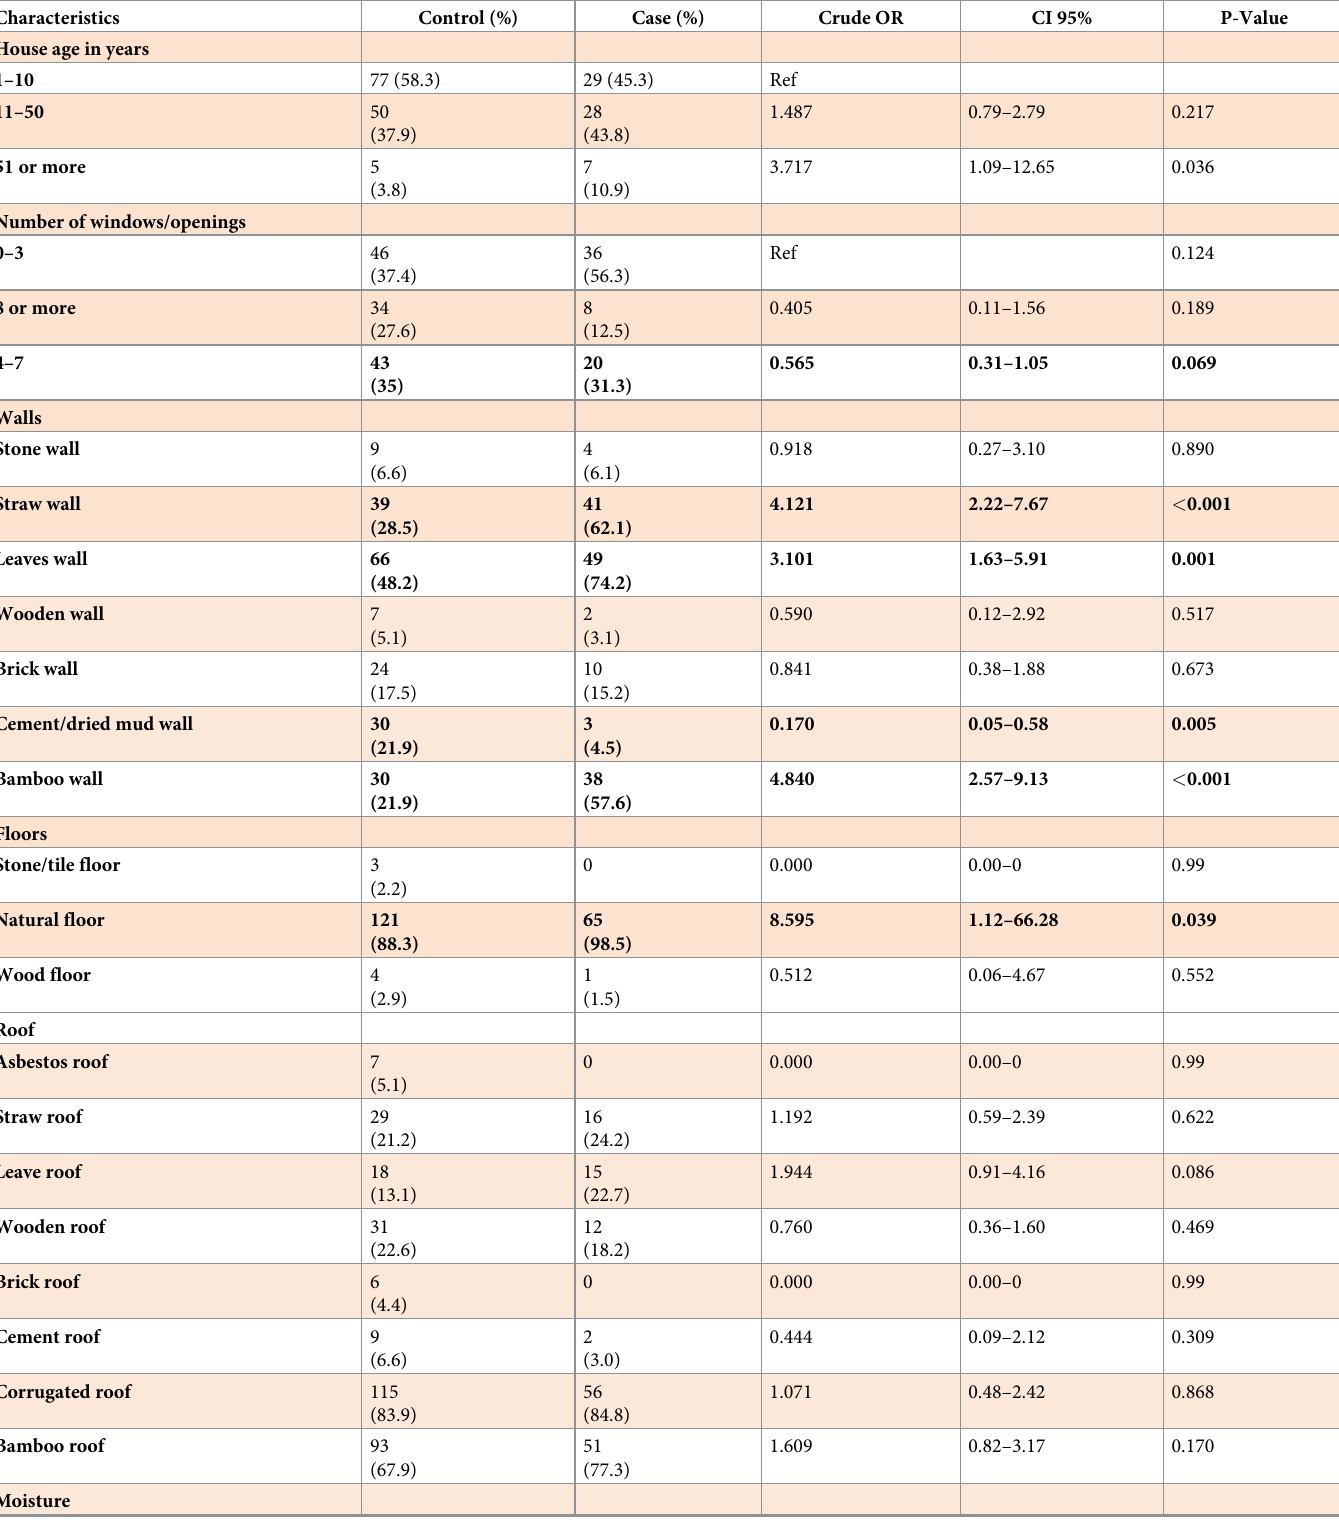
Table 1. Bivariate analysis of housing conditions with the occurrence of